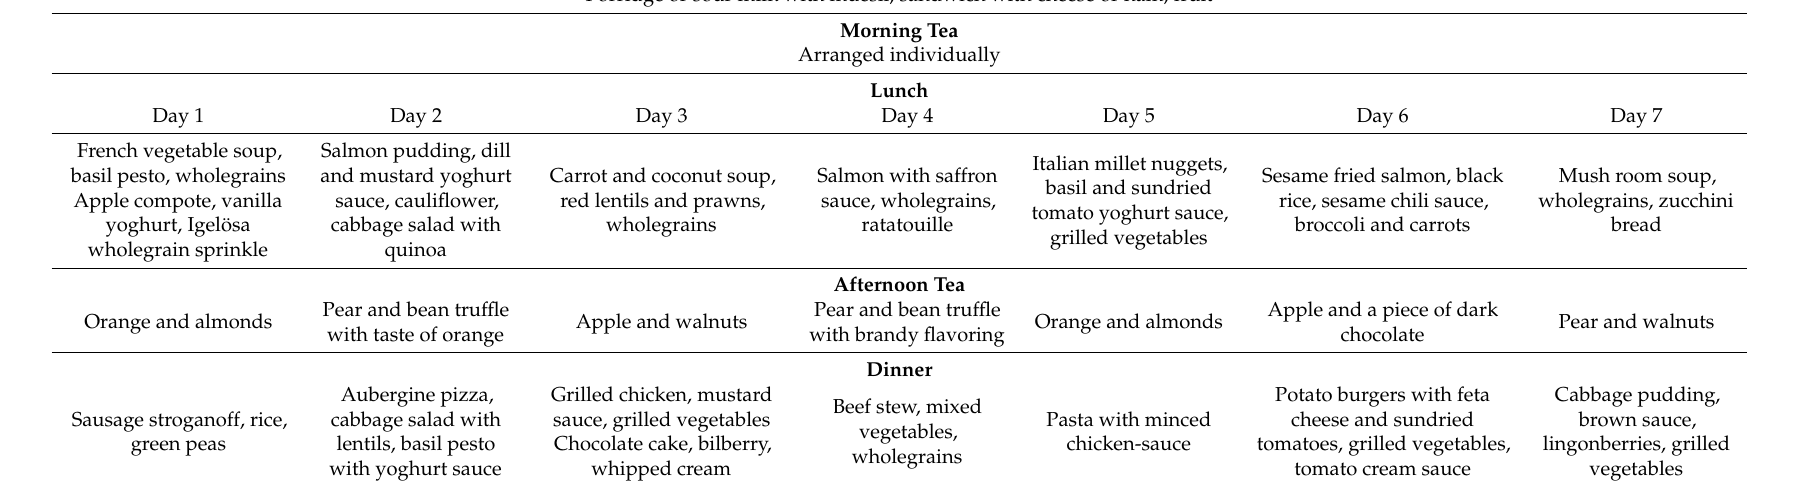
Table 4. One week of the Okinawan-based Nordic